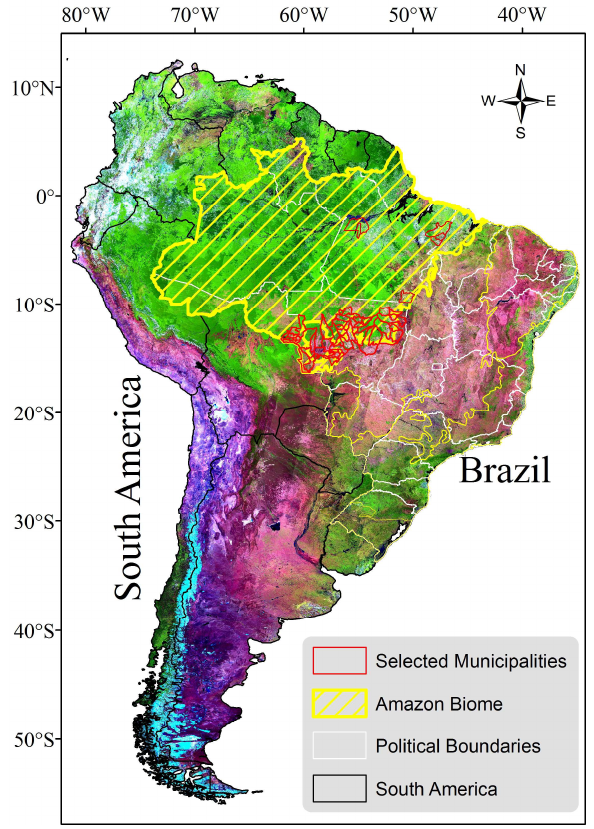
Figure 1. Location of the study area. Adapted from Rudorff et al.